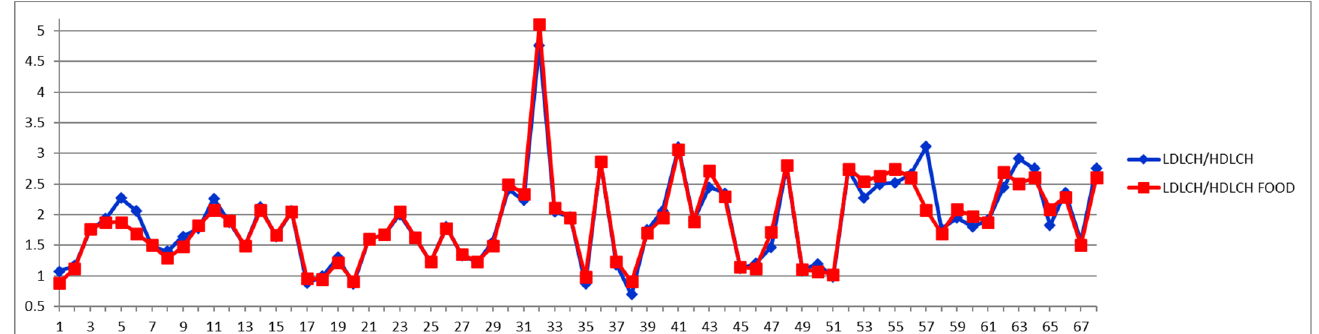
Figure 11. LDL/HDL cholesterol ratios in fasting and postprandial status in fasting (blue) and postprandial (red) status for control cases (1–29) and CVD cases (30–68).